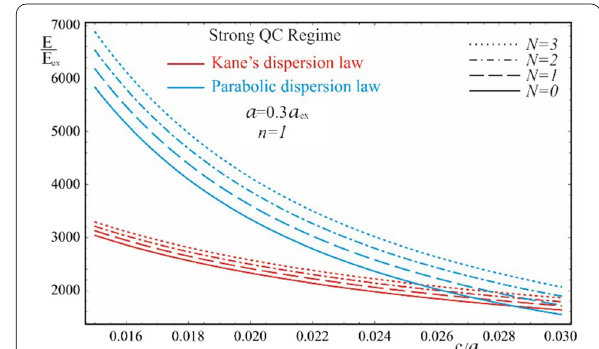
Fig. 5 The dependence of the first family of the energy levels on the minor semiaxis c at the fixed value of the major semiaxis a for the Kane’s and parabolic dispersion laws of CCs